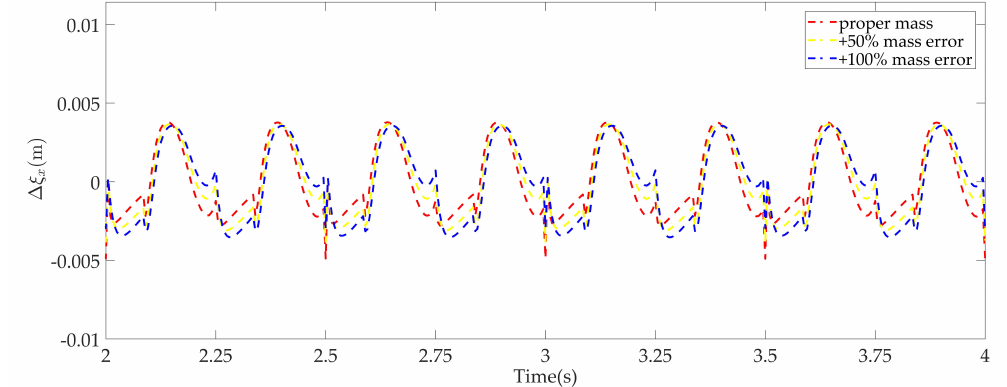
Figure 12. ξ x error of different mass error.